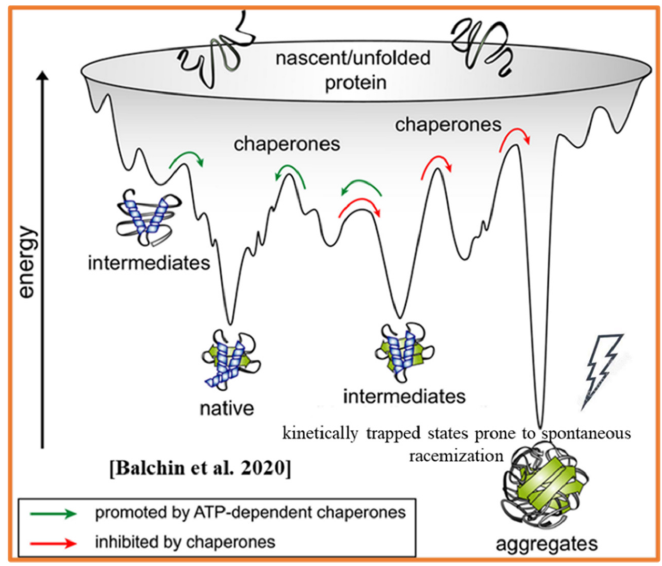
Figure 1. Funnel-shaped potential free-energy landscape. Impact of spontaneous racemization. Adopted with alterations from [25]. One of them is the gain of enthalpy under forces of the binding (condensation). Two